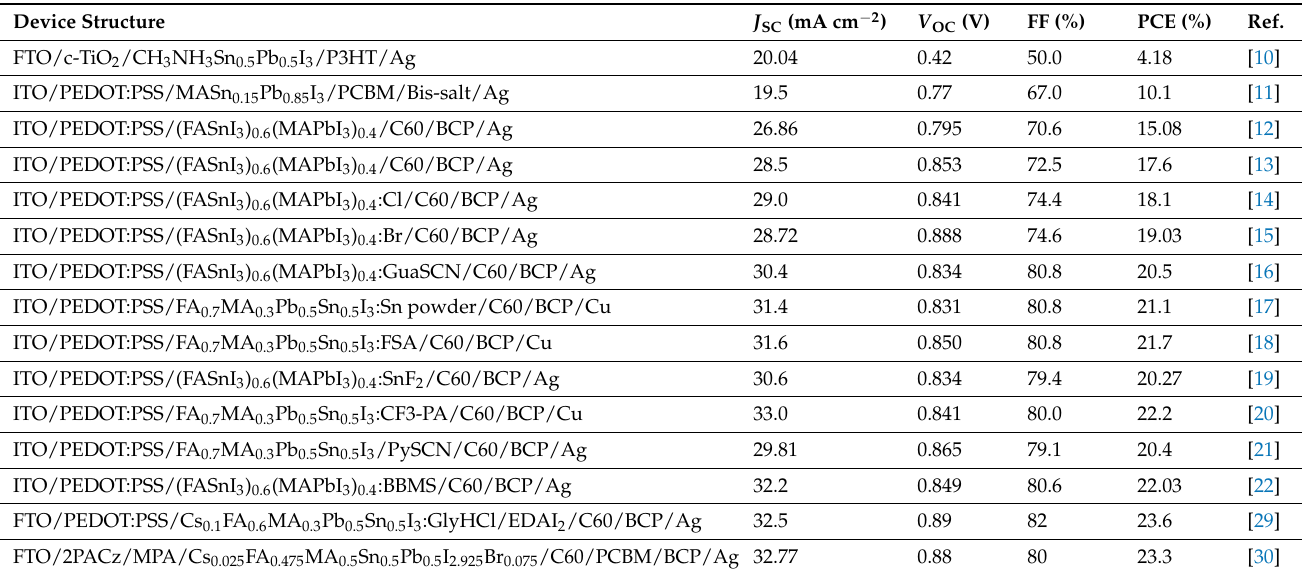
Table 1. Summary of the photovoltaic parameters of low-E g Sn-Pb PSCs with the best